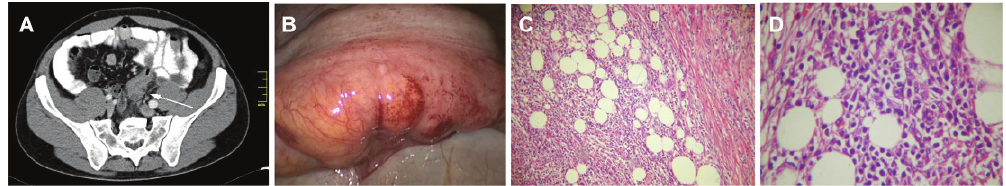
Figure 1 - A: Abdominal and pelvic CT scan showing mural thickening of the sigmoid colon with densification of the adjacent mesenteric fat (white arrow) and an increased number of lymph nodes up to 1.0 cm in diameter near the inferior mesenteric vessels; B: Surgical photography showing the inflamed sigmoid; C and D: microscopic exam after hematoxylin-eosin staining showing an extensive lymphoplasmocytic inflammatory infiltrate with collagenic deposition involving the mesenteric adipocytes at 100x (C) and 400x (D) magnifications.